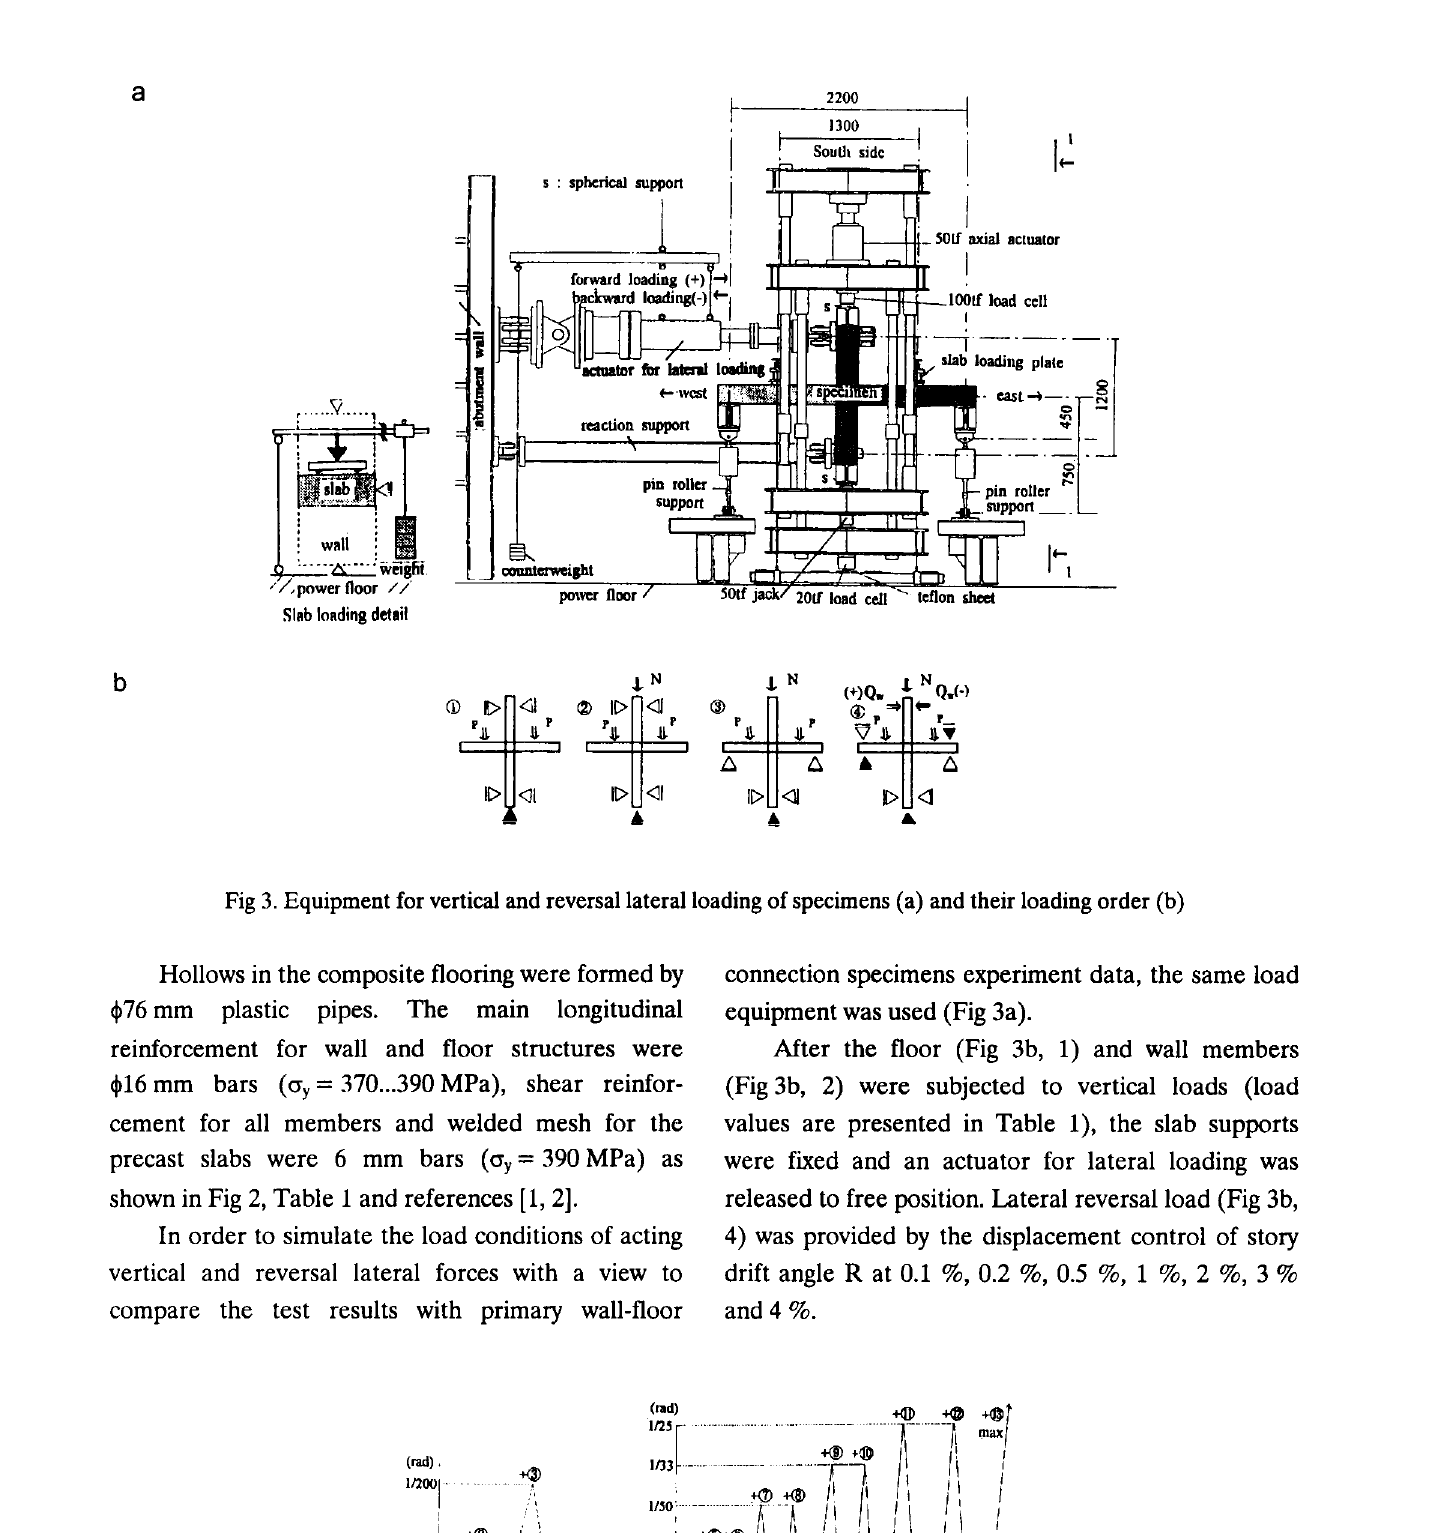
Fig 4. Loading program for wall-floor